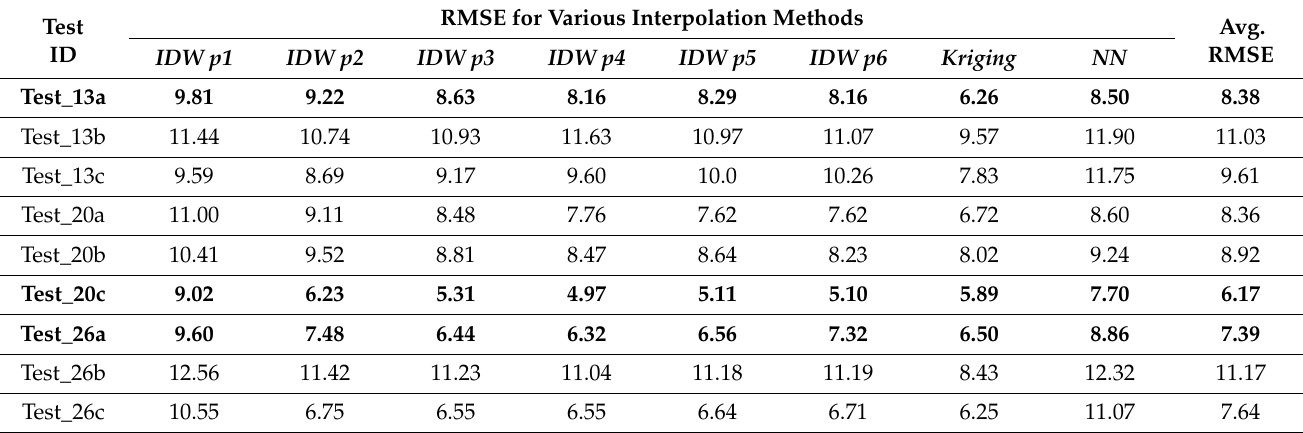
Table 2. RMSE (Root Mean Square Error) for individual tests and various interpolation